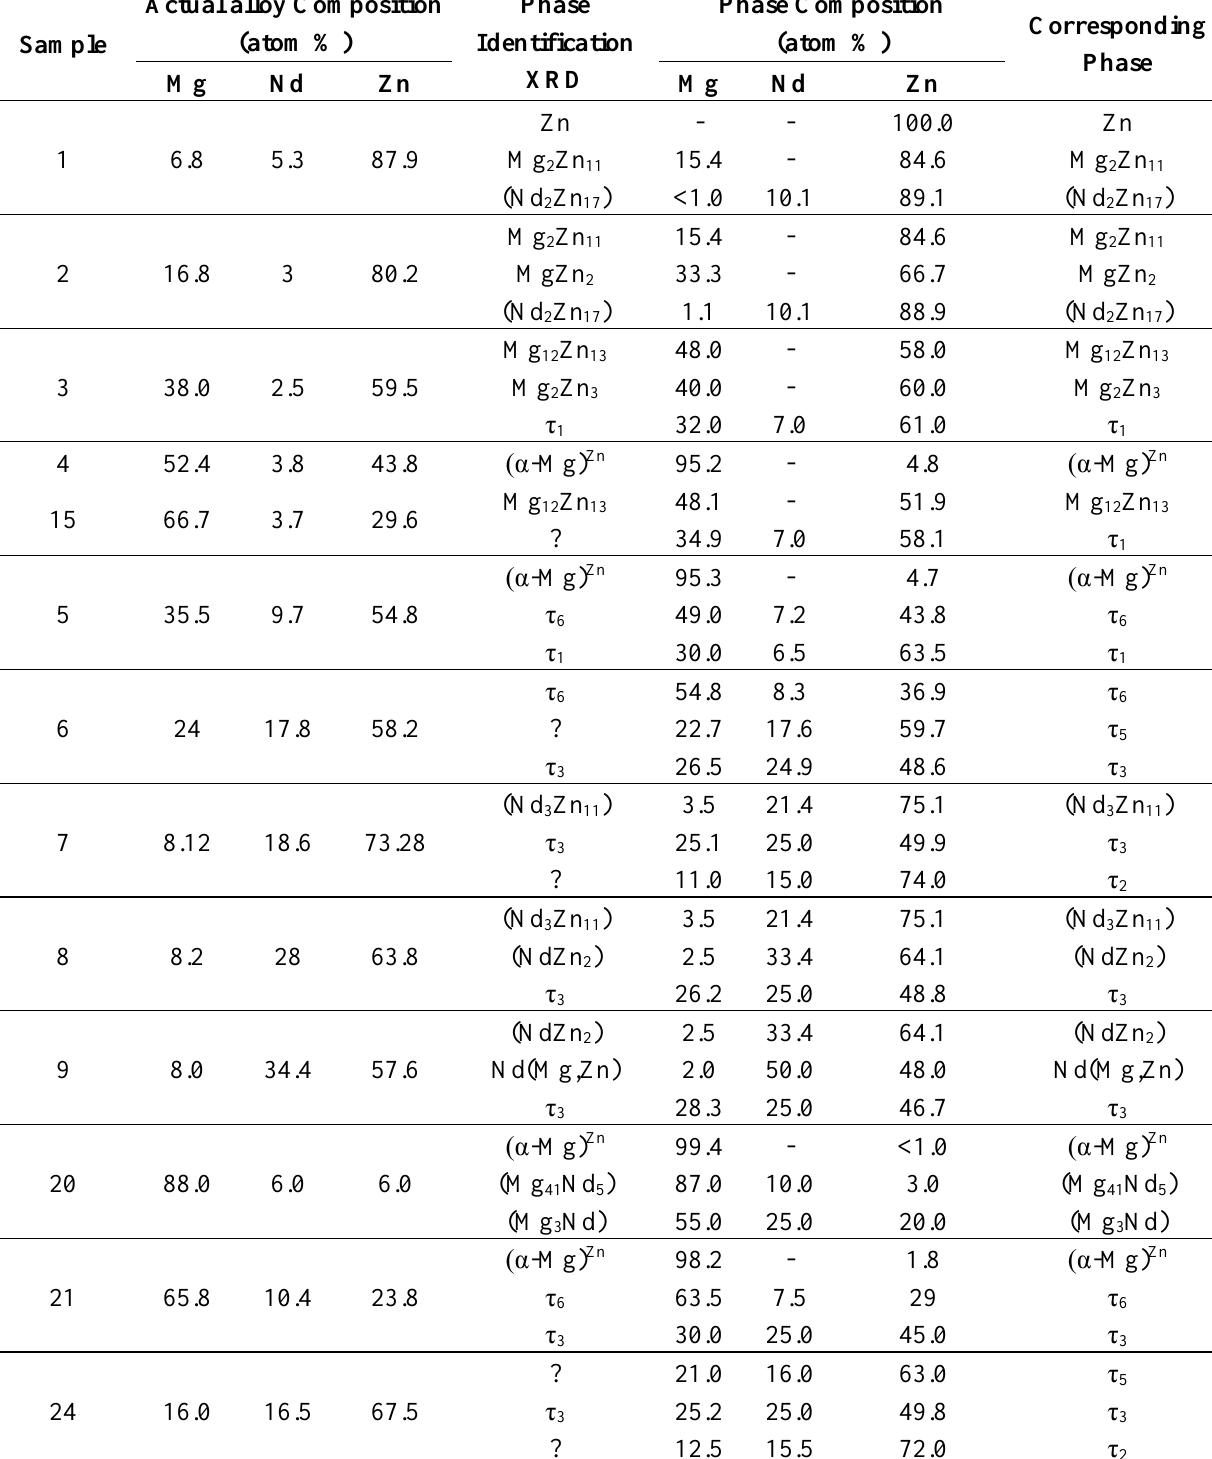
Table 3. Actual composition of key alloys containing three-phase equilibria and their experimental